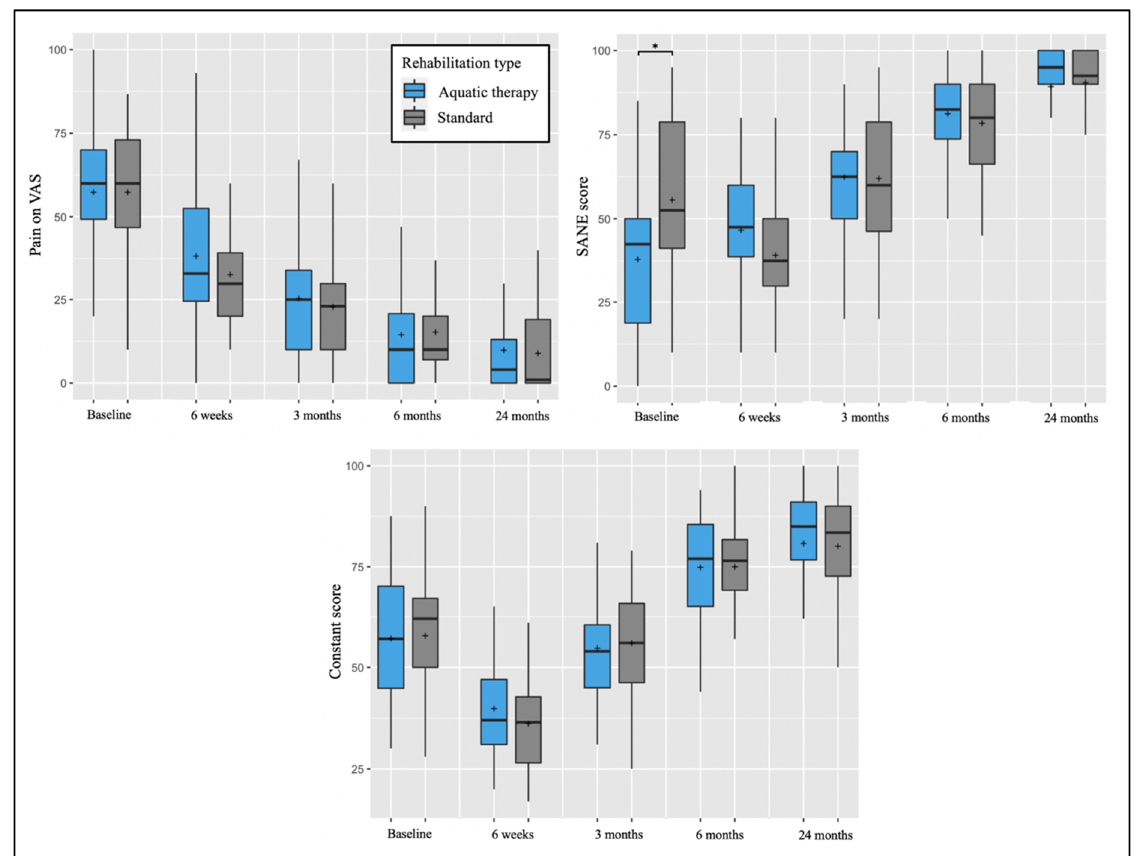
Figure 3. Pre-operative and post-operative pain on VAS, SANE, and Constant scores depending on post-operative rehabilitation (aquatic therapy vs. standard). The plots illustrate median values (bold lines), means (+), interquartile ranges (boxes), and 95% CIs (whiskers). * A significant difference was found between groups at the same follow-up point.